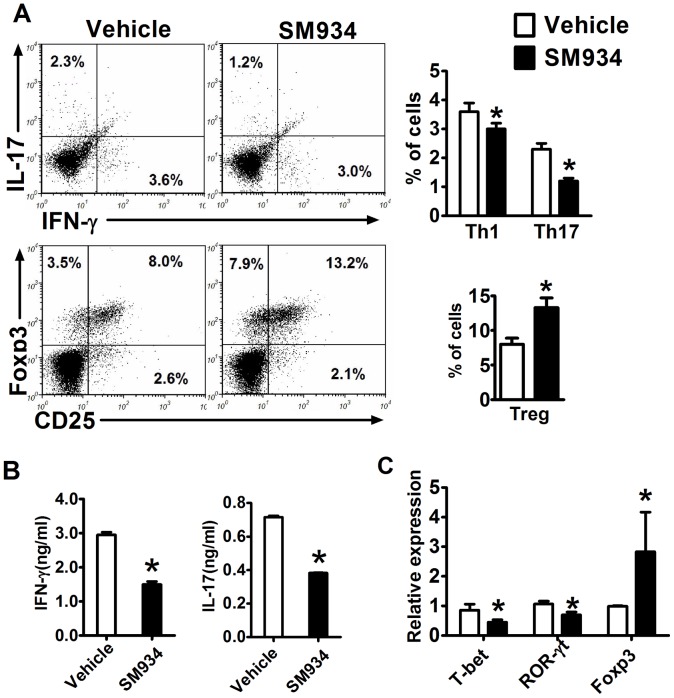
Effects of SM934 on the polarization of CD4+ T cells in EAE mice.Splenocytes from immunized mice treated with vehicle or SM934 were isolated at the peak of disease (day 18 p.i.) and analyzed. (A) The percentage of Th1, Th17 and Treg cells in the CD4+ gate were analyzed by flow cytometry, values in the bar graphs are the mean ± SEM (n = 4). (B) Splenocytes were re-stimulated with IL-12 (20 ng/ml) or IL-23 (20 ng/ml) for 72 hours, and supernatants were collected to measure IFN-γ and IL-17 levels, respectively. (C) RNA from splenocytes was analyzed by real-time PCR for expression of T-bet, RORγt and Foxp3. Results were expressed as mean ± SEM. *, p<0.05 compared with vehicle control. Three independent experiments were performed with similar results.